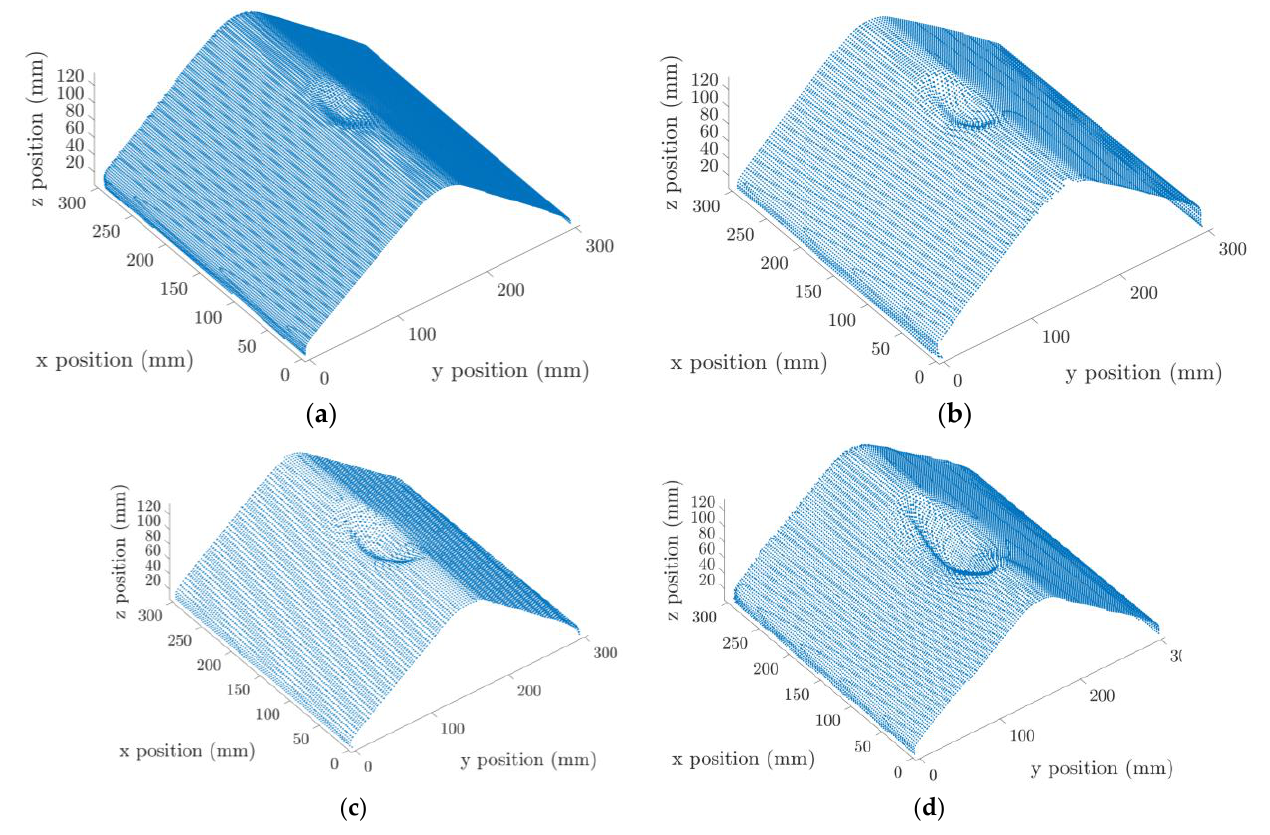
Figure 7. 3D profiles of blast tested V-structures (105° internal angle, 32 mm tip radius) tested at ( a ) 10 g, ( b ) 15 g, ( c ) 20 g and ( d ) 40 g.